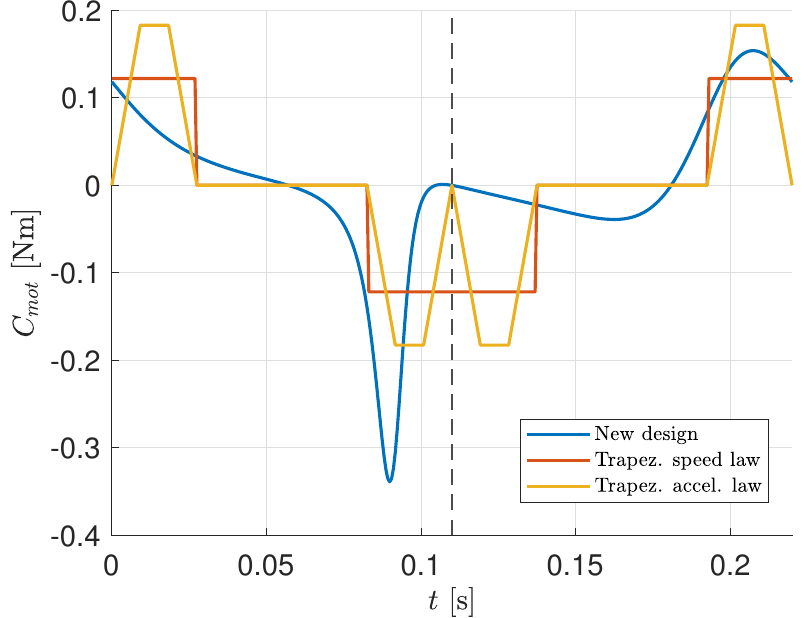
Figure 10. Motor torques for different design solutions. Proposed design (blue) and direct motor installed on the rotary distributor: trapezoidal speed law (orange) and trapezoidal acceleration law